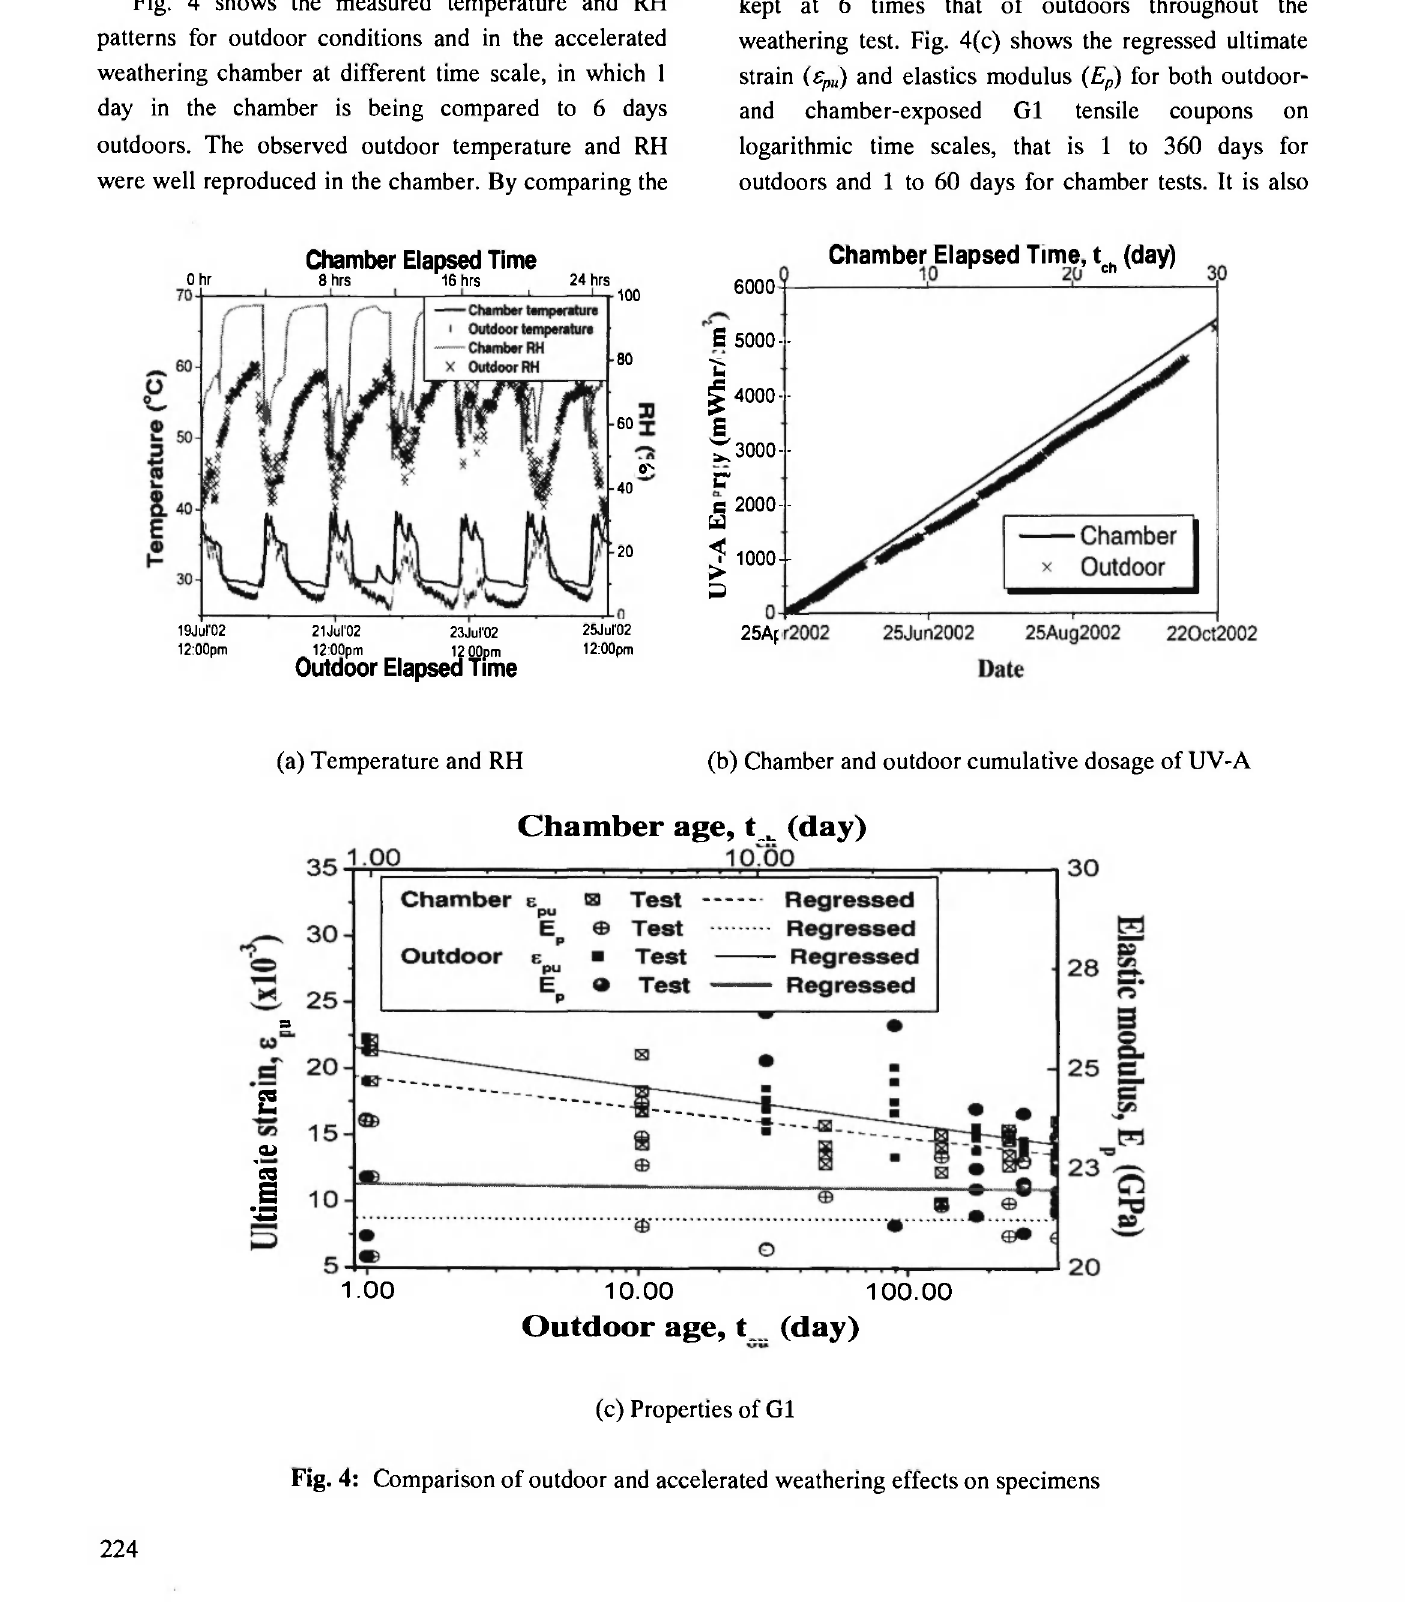
Fig. 4: Comparison of outdoor and accelerated weathering effects on